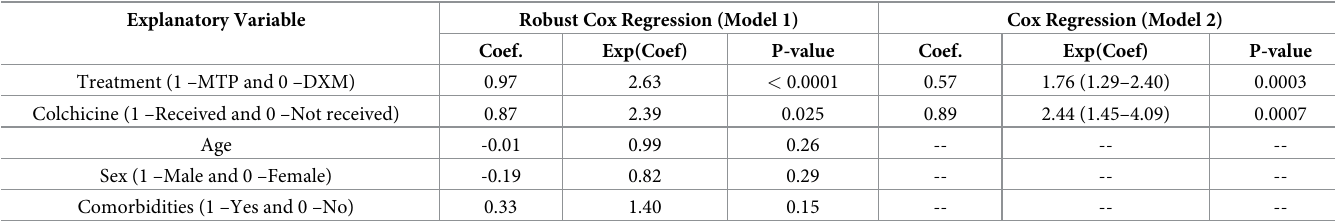
Table 3. Recovery time performance analysis—Cox